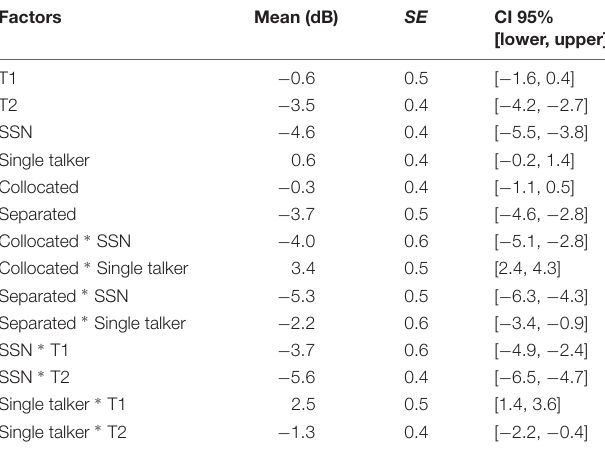
TABLE 2 | Estimated marginal mean speech-reception thresholds (SRTs), standard error (SE) and the lower and upper range of the 95% confidence intervals (CI 95%) for the main effects and